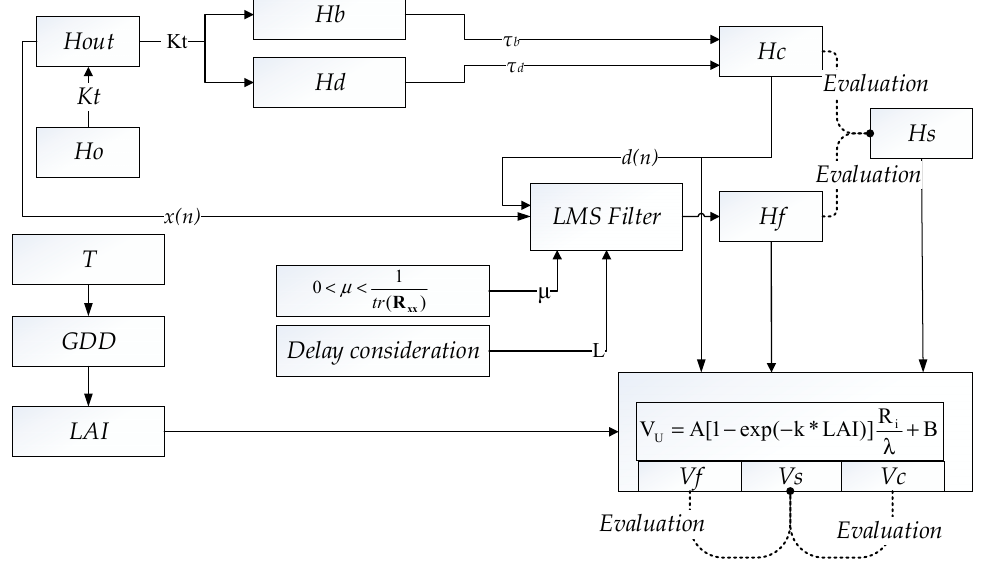
Figure 2. Flow chart of solar radiation estimation, water requirement calculation, and corresponding evaluations in this study. LMS = least mean squares.